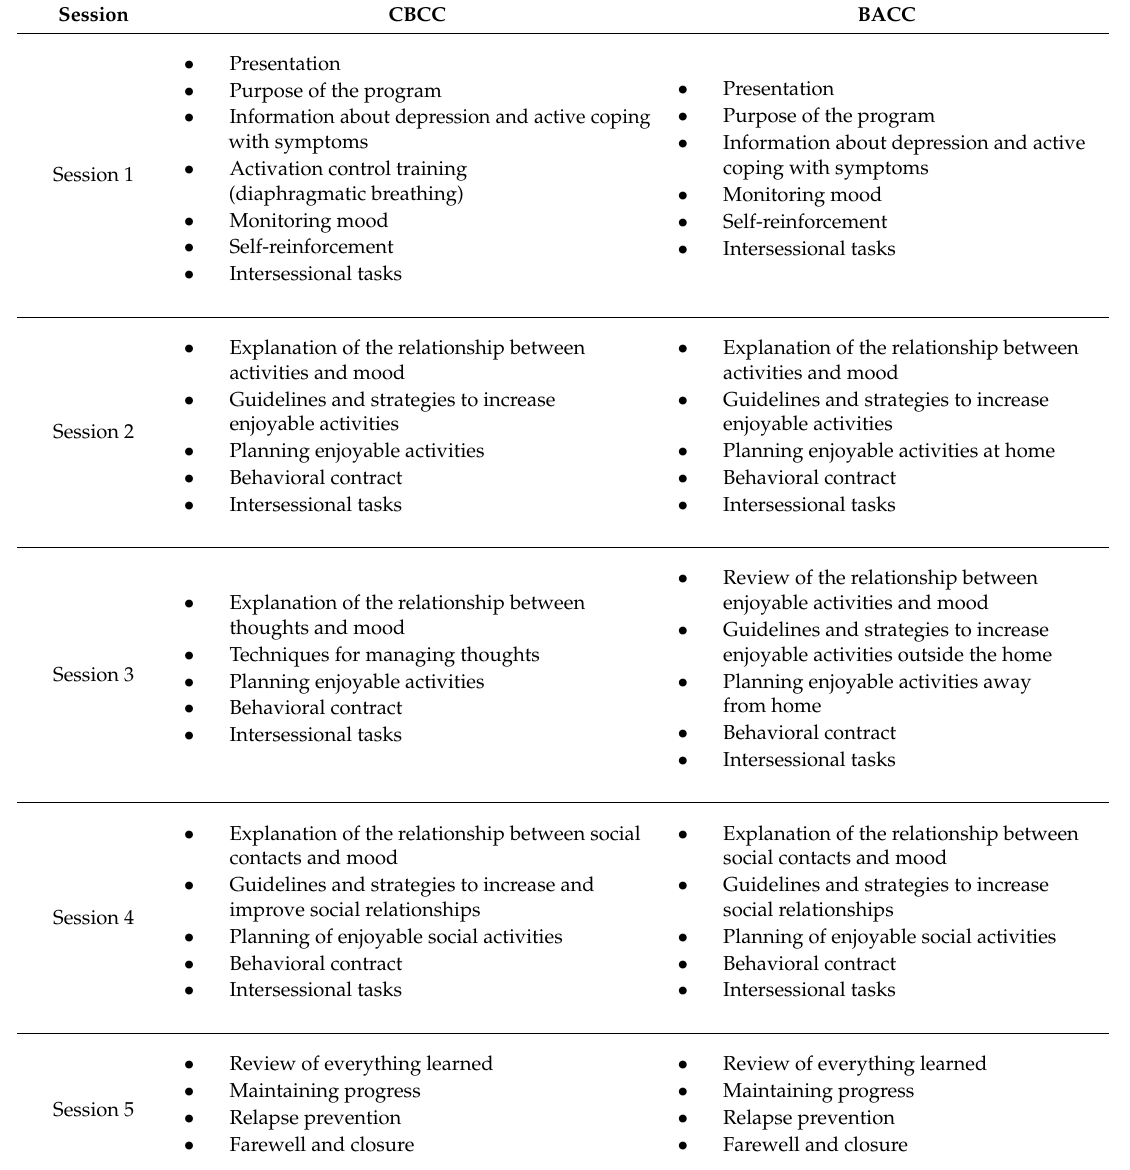
Table 1. Contents of the indicated depression prevention interventions administered by telephone conference